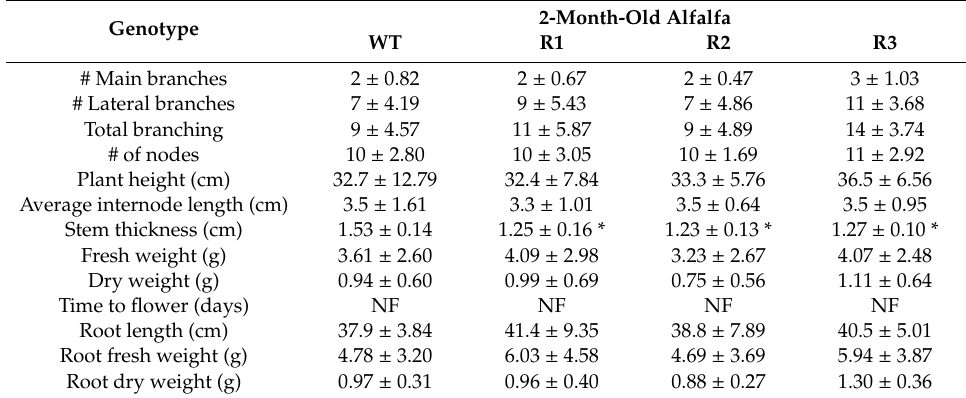
Figure 1. MsSPL9 transcript abundance in RNAi-silenced Squamosa Promoter Binding Protein-Like 9 ( SPL9 -RNAi) transgenic alfalfa: the asterisks indicate significant differences between transgenic and wild-type (WT) plants ( p < 0.05, where n = 3, one-way ANOVA and Dunnett’s test). Table 1. Physiological traits measured in two-month-old WT and SPL9 -RNAi transgenic alfalfa: the asterisks indicate significant differences between transgenic and WT plants ( p < 0.05, where n = 10, one-way ANOVA and Dunnett’s test).